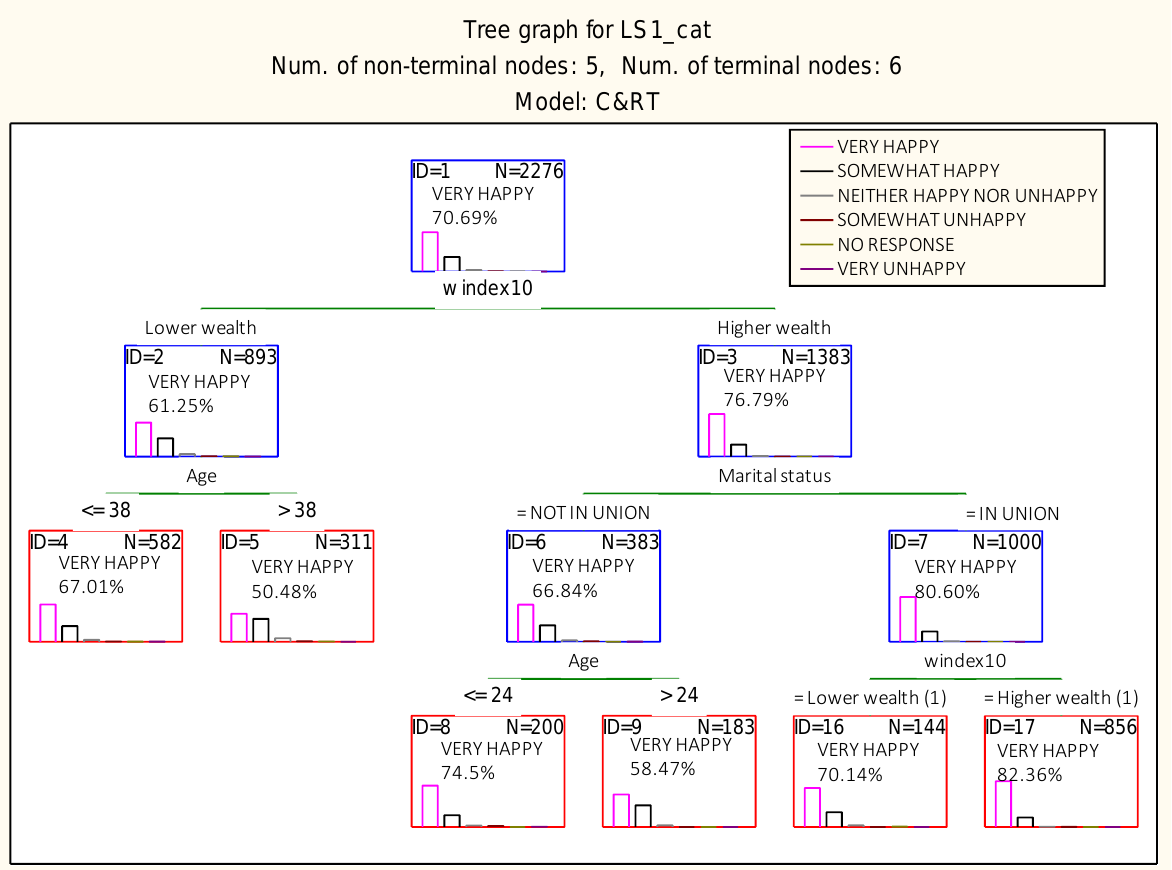
Figure 1. C&RT graphic of selected variables with impact upon happiness* Tree graph for LS1_cat Num. of non-terminal nodes: 5, Num. of terminal nodes: 6 Model: